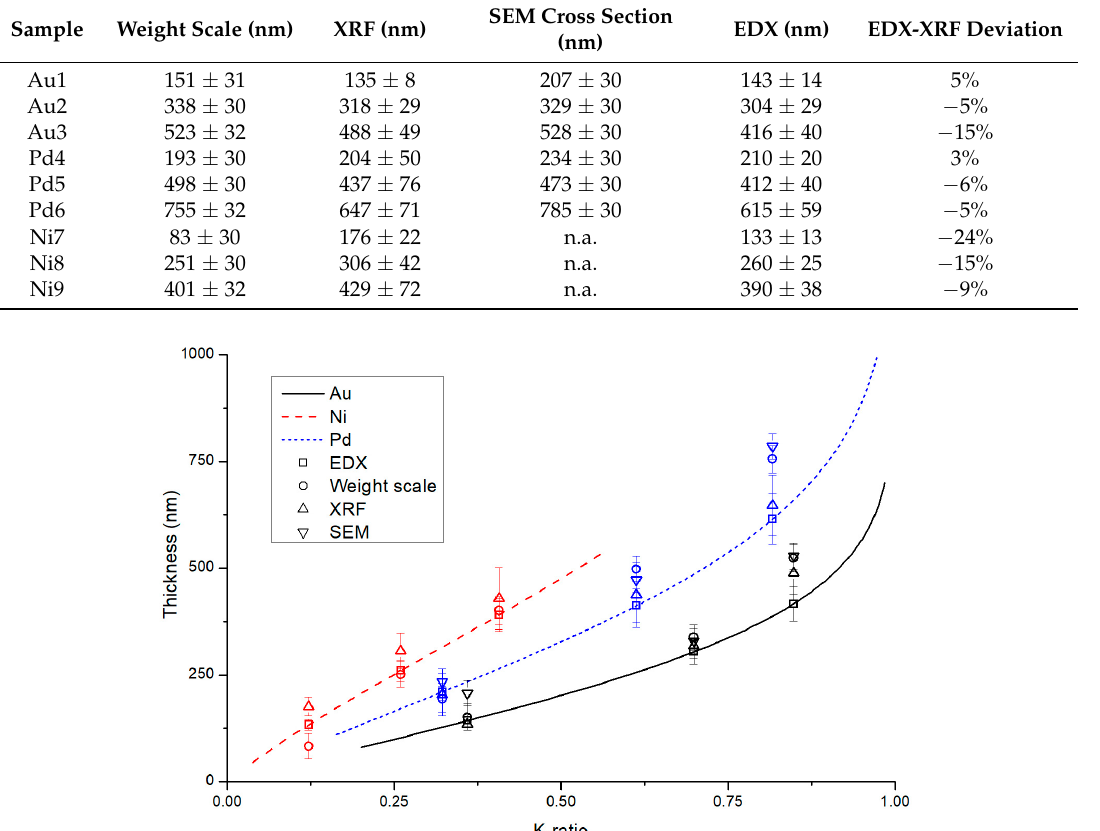
Table 2. Measured thickness values with all the different measurement methods. For EDX the result derived from the simulations of the combination BICS/DTSA2 is reported, which has the smallest deviation respect to XRF, considered as the reference value. We also reported the deviation between EXD and XRF for all individual measurements.